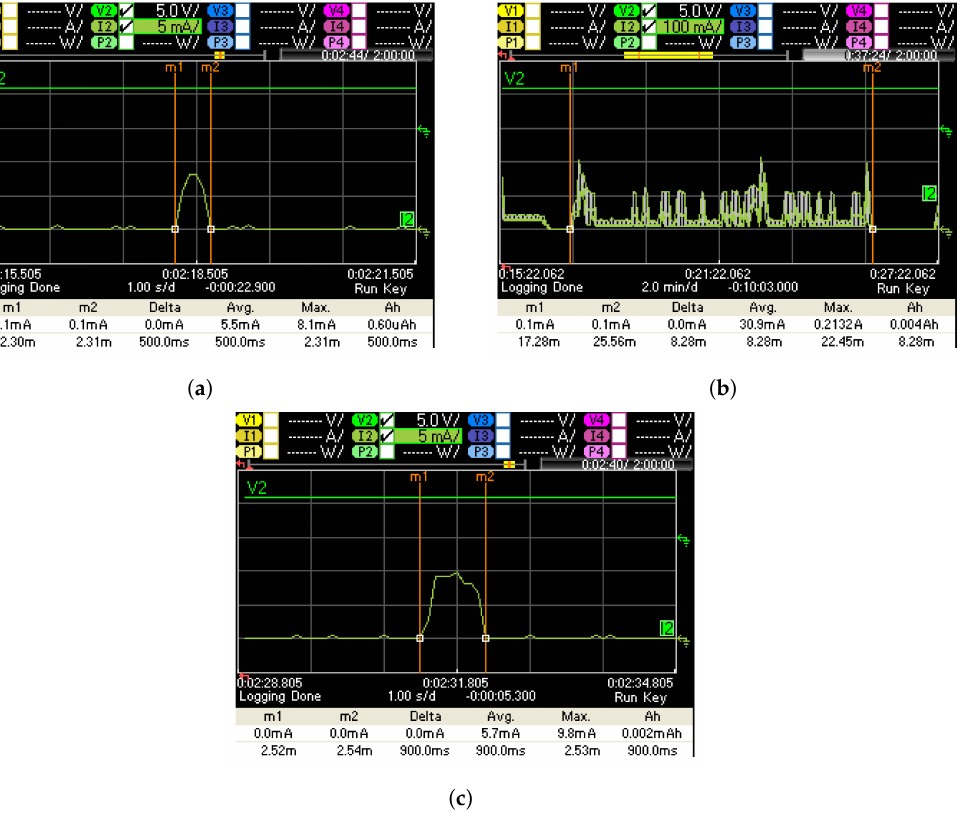
Figure 9. ( a ) Current consumption rain pulse—measurement 1 at 6 V, ( b ) current consumption minutes time slot + data retrieval—measurement 1 at 6 V, ( c ) current consumption logging interval 00:00 h—measurement 1 at 6 V.